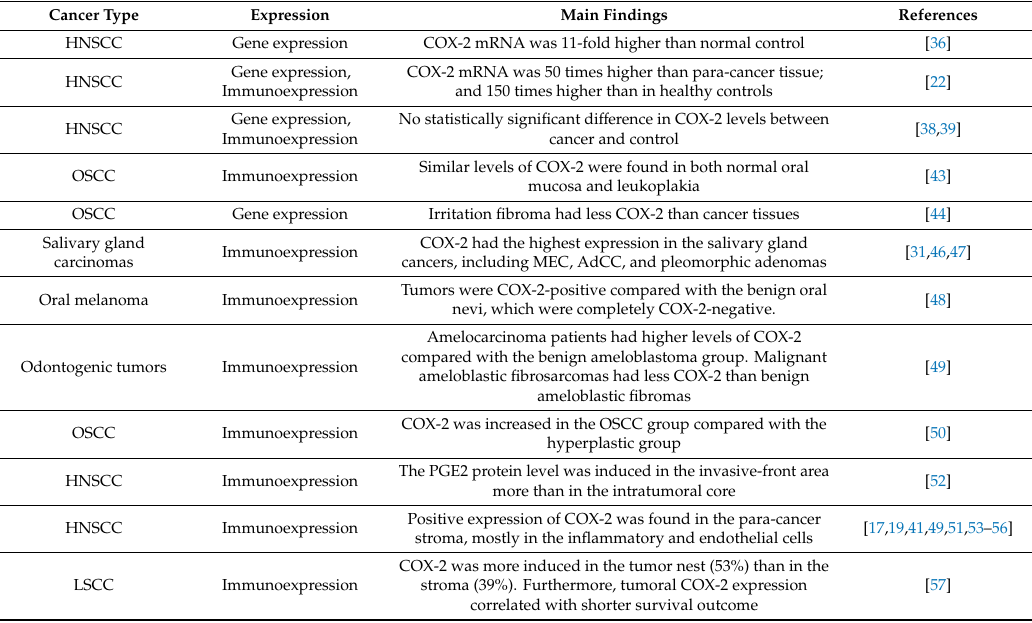
Table 1. Summary of COX-2 expression in di ff erent types of head and neck